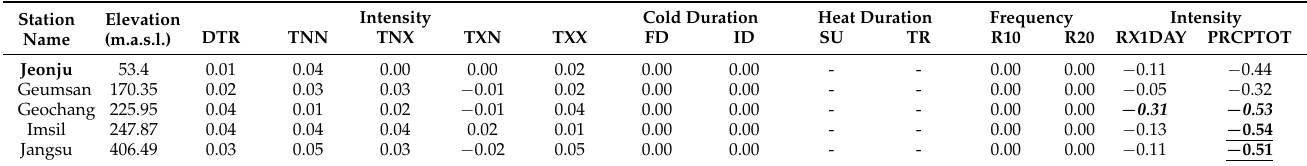
Table A7. Trend magnitudes for the month of January in the UGRB for 33 years